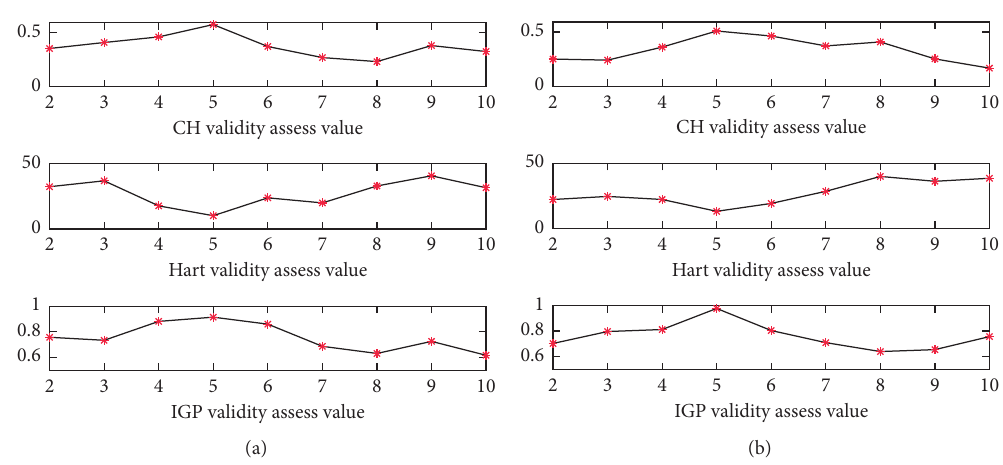
Figure 4: Three validity assessment indexes illustration: (a) validity indexes in 2014; (b) validity indexes in 2015.